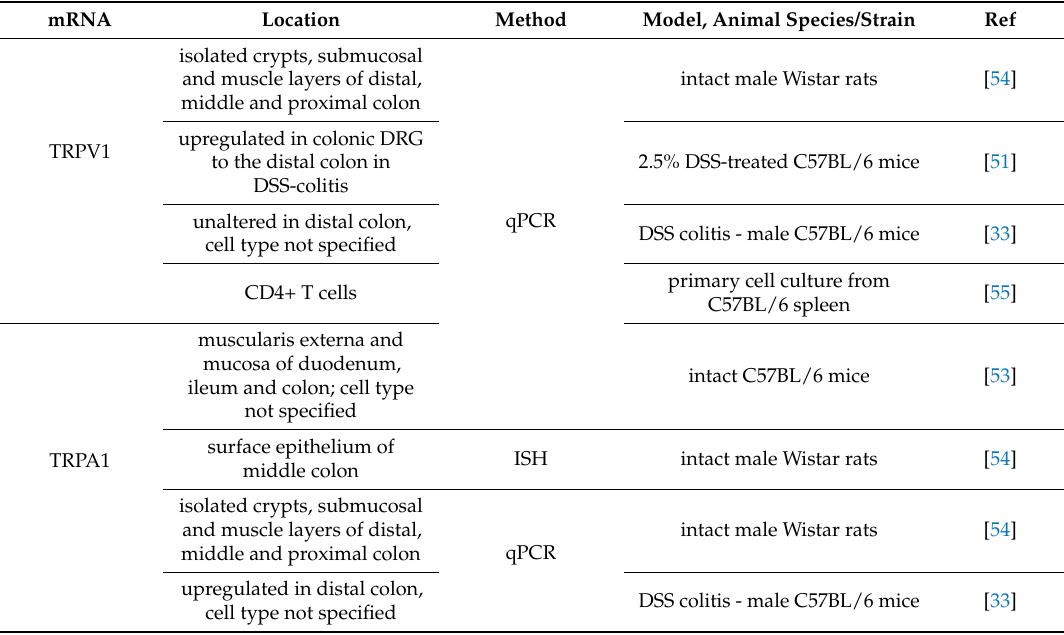
Table 3. mRNA expression of TRPV1 and TRPA1 in the animal colon (ISH: in situ hybridization).